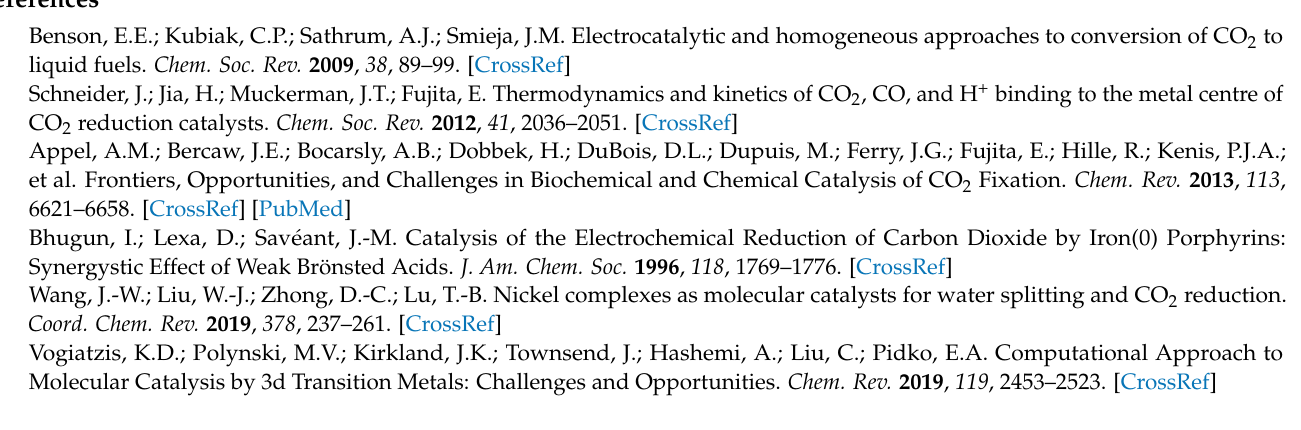
Supplementary Materials: The following data are available online. Table S1: B3LYP/6-311G* energies/enthalpies. Table S2: bond distances (Å) and angles ( ◦ ). Table S3: MPA charges. Table S4: QTAIM charges. Table S5: QTAIM BCP characteristics. Table S6: Mulliken populations of localized orbitals of complexes studied. Figure S1: comparison of chosen geometries. Figure S2 and Figure S3: frontier orbitals. SI_XYZ.zip contains the xyz geometries as separate files and XYZ_compounds.pdf contains the compounds’ label, energy, enthalpy, and xyz file